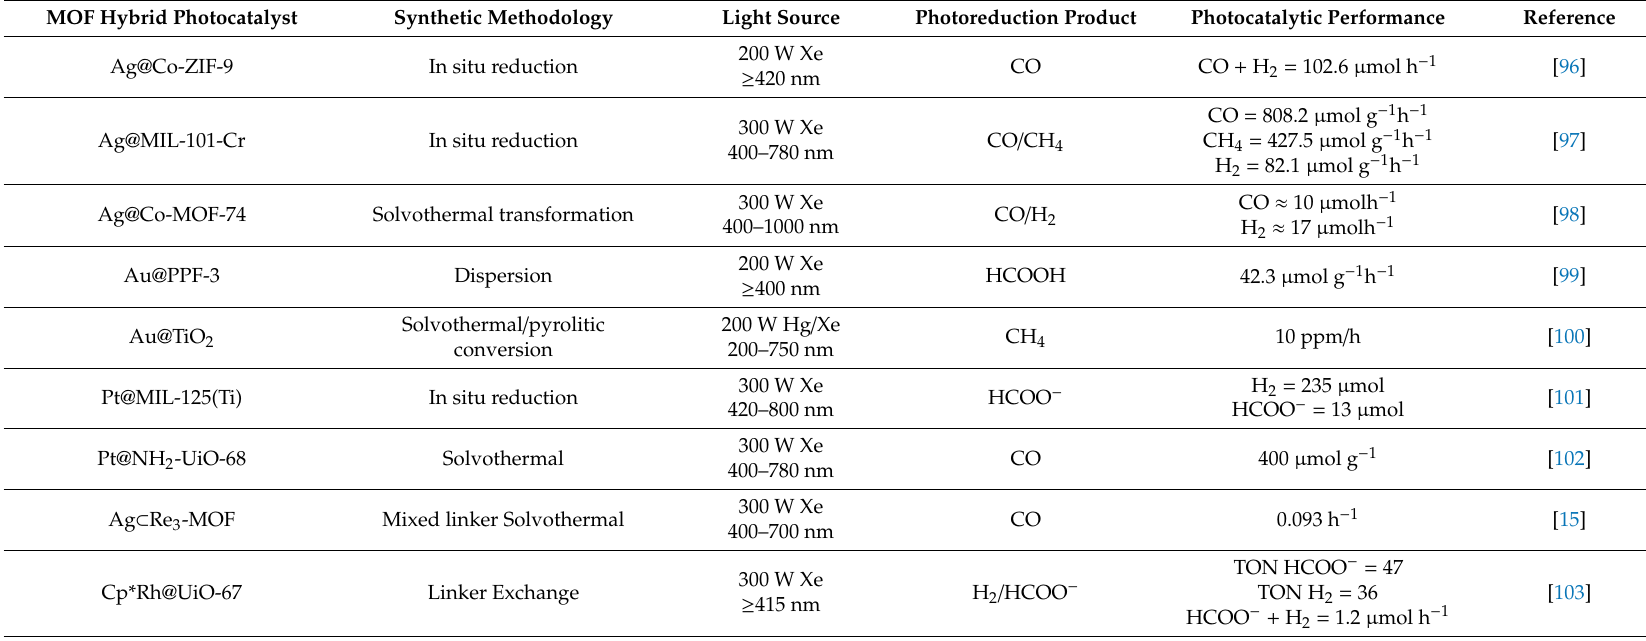
Table 2. Noble metal species incorporated within MOFs for photocatalytic CO 2